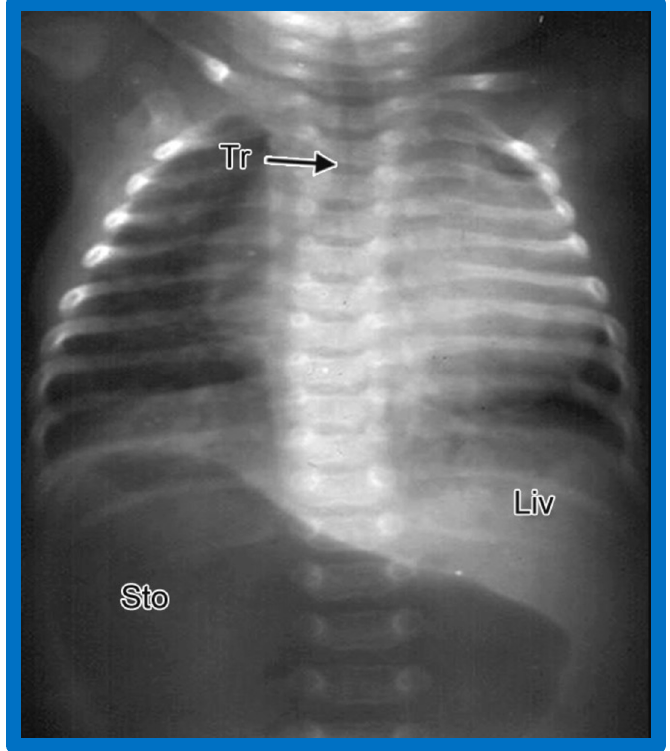
Figure 11. A chest roentgenogram of a baby who has isolated levocardia. The heart is on the left side, which is normal (levocardia), while the stomach (Sto) and the liver (Liv) are reversed (situs inversus). The marked dilatation of the Sto is likely due to intestinal obstruction secondary to malrotation of the gut. Modified from reference [4].